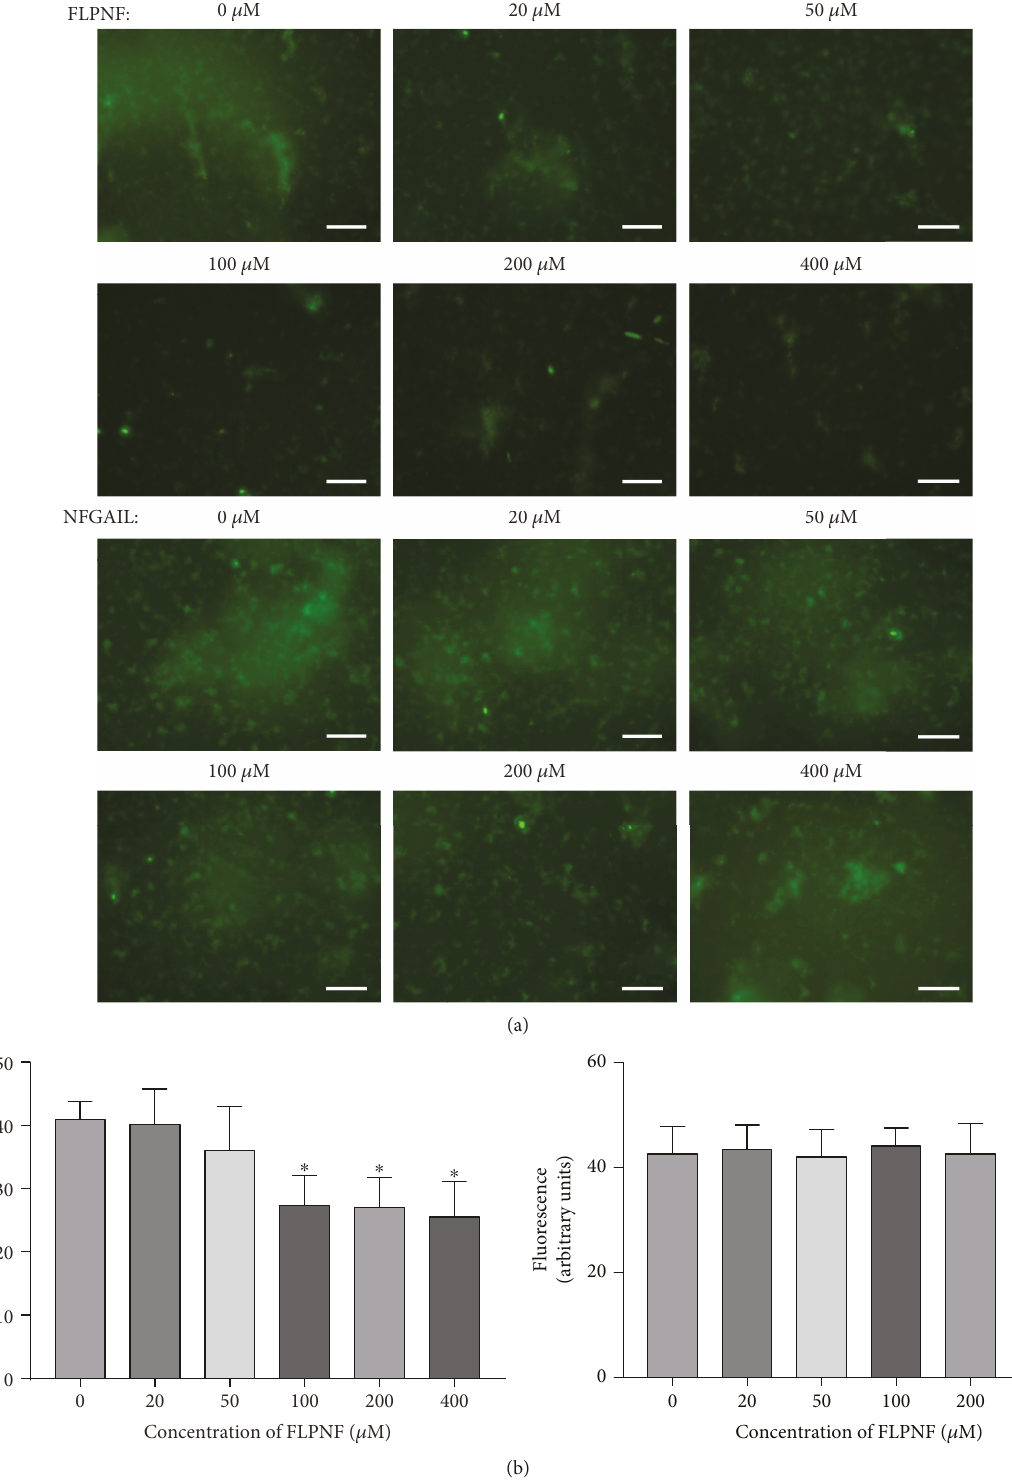
Figure 3: Analysis of inhibitory e ff ects of di ff erent concentrations of FLPNF and NFGAIL on hIAPP aggregation formation by ThT staining. 10 μ M hIAPP incubated with 0, 20, 50, 100, 200, and 400 μ M FLPNF or NFGAIL in PBS for 24 hours at 37 ° C. (a) ThT fl uorescence of each group was observed using a fl uorescence microscope (stained by 20 μ M ThT; scale bar: 50 μ m). (b) The fl uorescence intensity values of each group were measured by a luminescence meter for 24 hours (values were presented as means ± SD ; each experiment was repeated thrice; ∗ signi fi cantly di ff erent compared to 0 μ M, unpaired t -test, P < 0 05